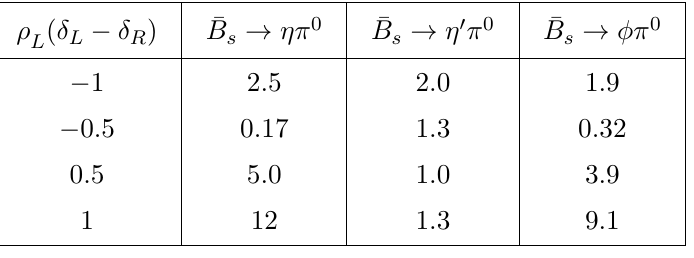
Table 3 . Enhancement factors of the branching fractions of (cid:22) B s ! ( (cid:17); (cid:17) 0 ; (cid:30) ) (cid:25) 0 with respect to their SM predictions at a few representative values of (cid:26) m = 1 TeV Z 0